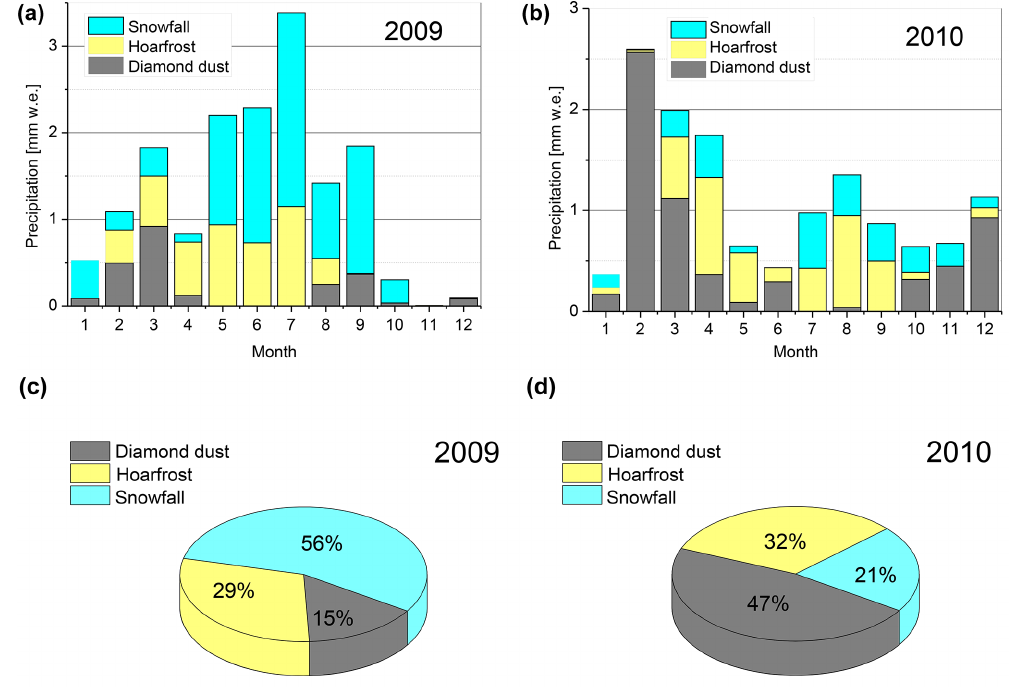
Figure 4. Monthly precipitation at Dome C (a) 2009 and (b) 2010, distinguishing three different types of precipitation: diamond dust, hoar frost, and snowfall. Relative frequency of diamond dust, hoar frost, and snowfall for (c) 2009 and (d) 2010. The types were determined from photos of the crystals on the platforms by the Avalanche Research Institute, Arabba,